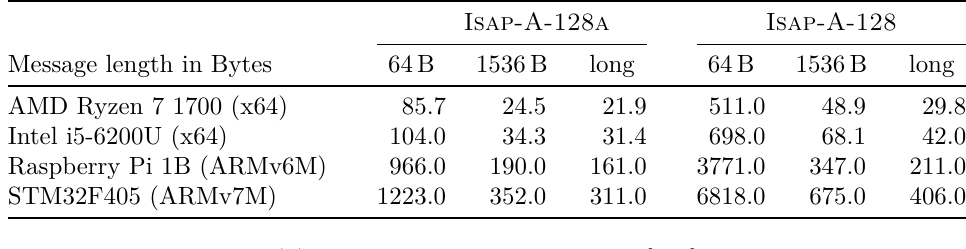
(b) Instances based on Keccak- p